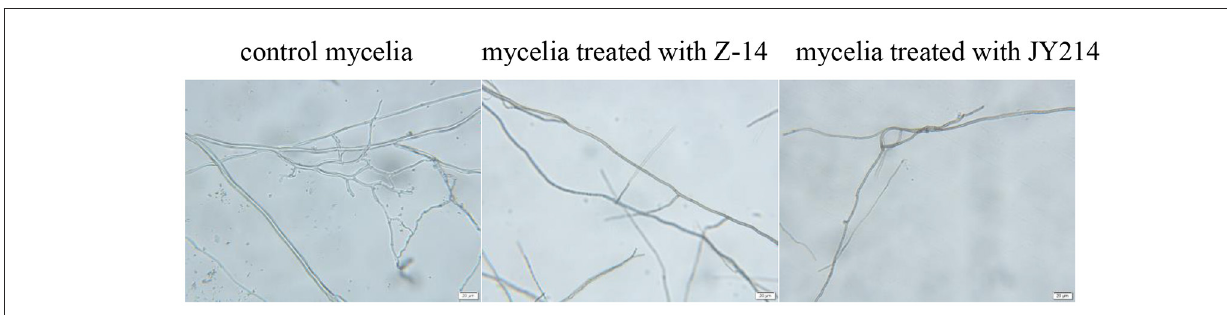
FIGURE7 Inhibition of Ggt mycelial growth by Z-14 and JY214. The Ggt mycelia treated with Z-14 and JY214 were observed under a microscope. Bars = 20 µ m.